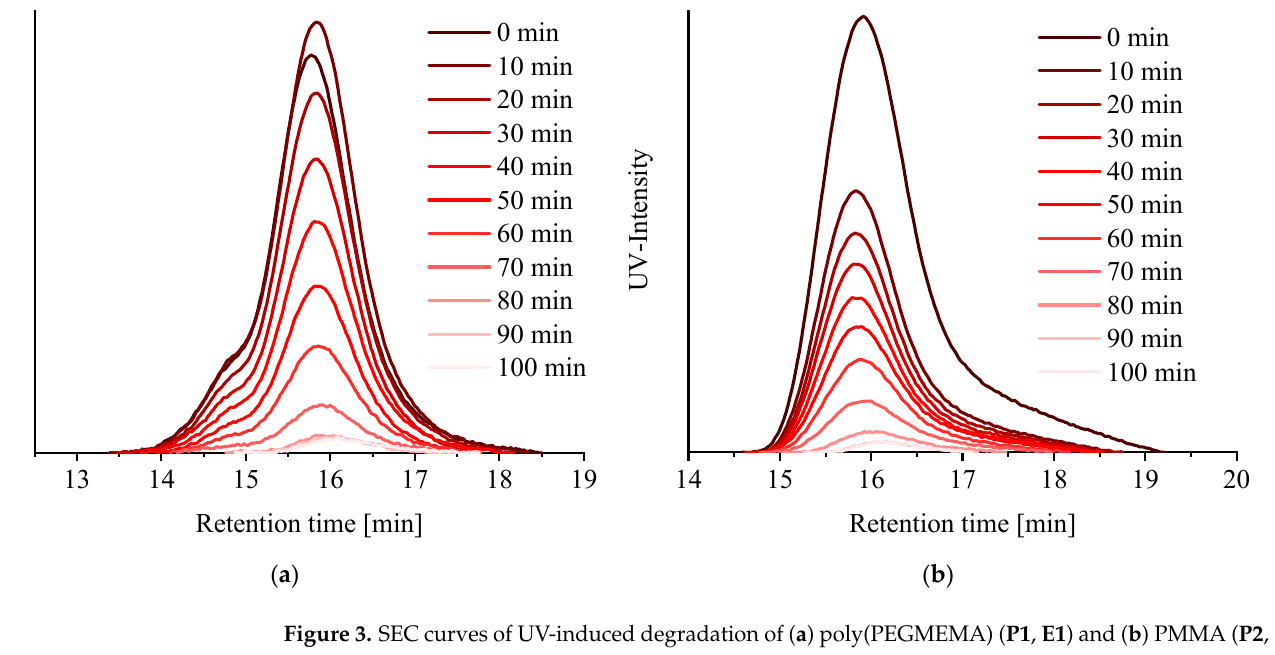
Figure 3. SEC curves of UV-induced degradation of ( a ) poly(PEGMEMA) ( P1 , E1 ) and ( b ) PMMA ( P2 , E8 ). Samples were taken every 10 min for a period of 100 min (chloroform/isopropanol/triethylamine (94/2/4); ( a ) PEG standard and ( b ) PMMA standard).